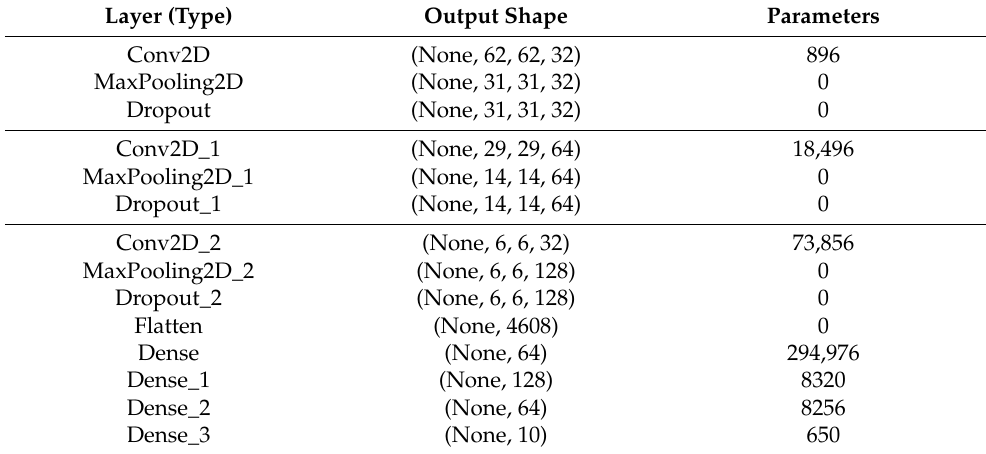
Table 2. AlexNet